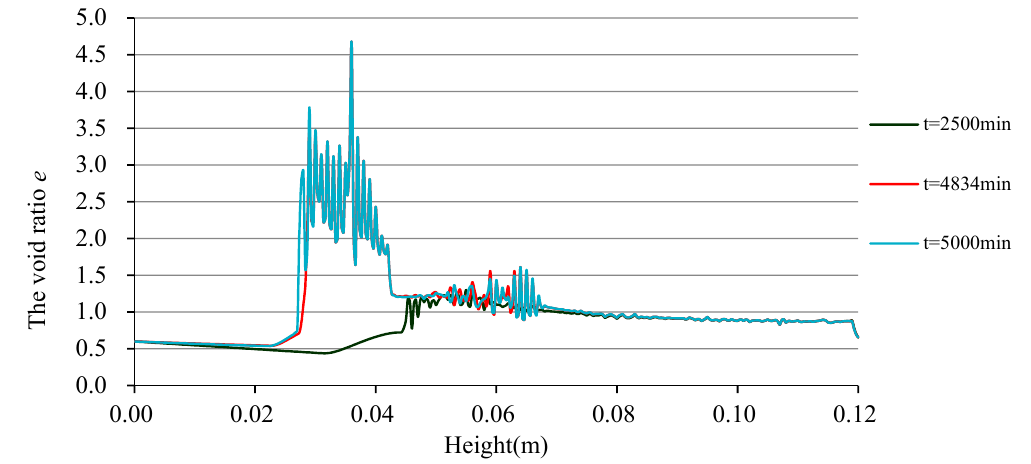
Figure 9. Distribution of void ratio at different durations of freezing.